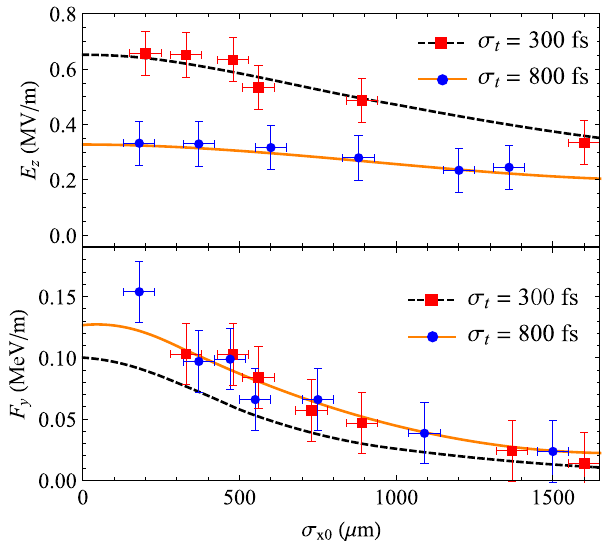
FIG. 6. Average longitudinal E z and transverse F y wakefield strengths as a function of the rms beam size at the position of the DLW. E z is measured with the structure half-gap of a ¼ 1 . 0 mm and beam centered. F y is measured with a ¼ 2 . 0 mm and y 0 ¼ ¼ 800 and 300 fs were used. 1 . 34 mm : rms bunch lengths of σ t The lines are corresponding simulation